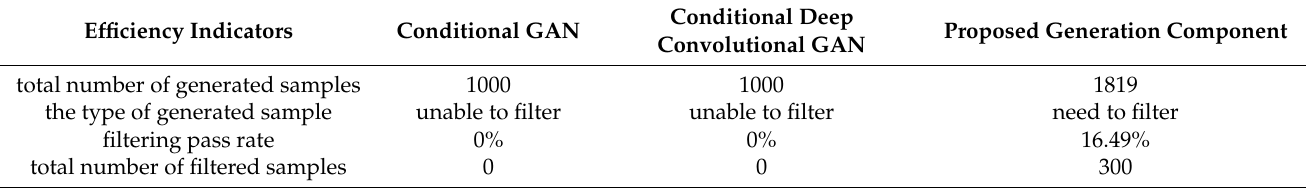
Table 1. The comparison results of different generated samples through the filtering model.